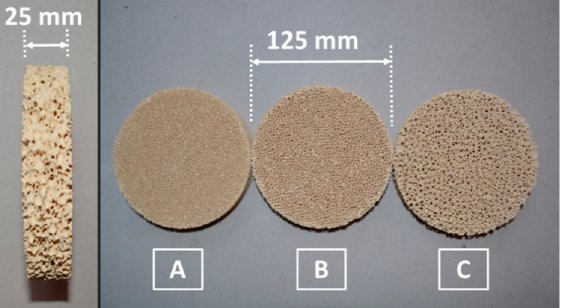
Figure 1. Volumetric absorbers used in experimental tests. partially stabilized zirconia (PSZ) foam filters with pore density: ( A ) 30 PPI (pores per inch), ( B ) 20 PPI, and ( C ) 10